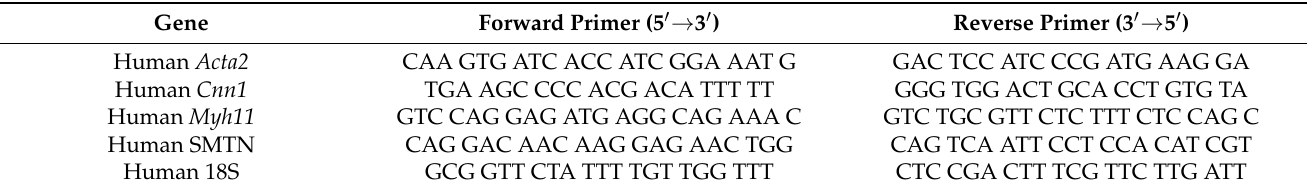
Table 1. qRT-PCR primer sequences for human-specific mRNA